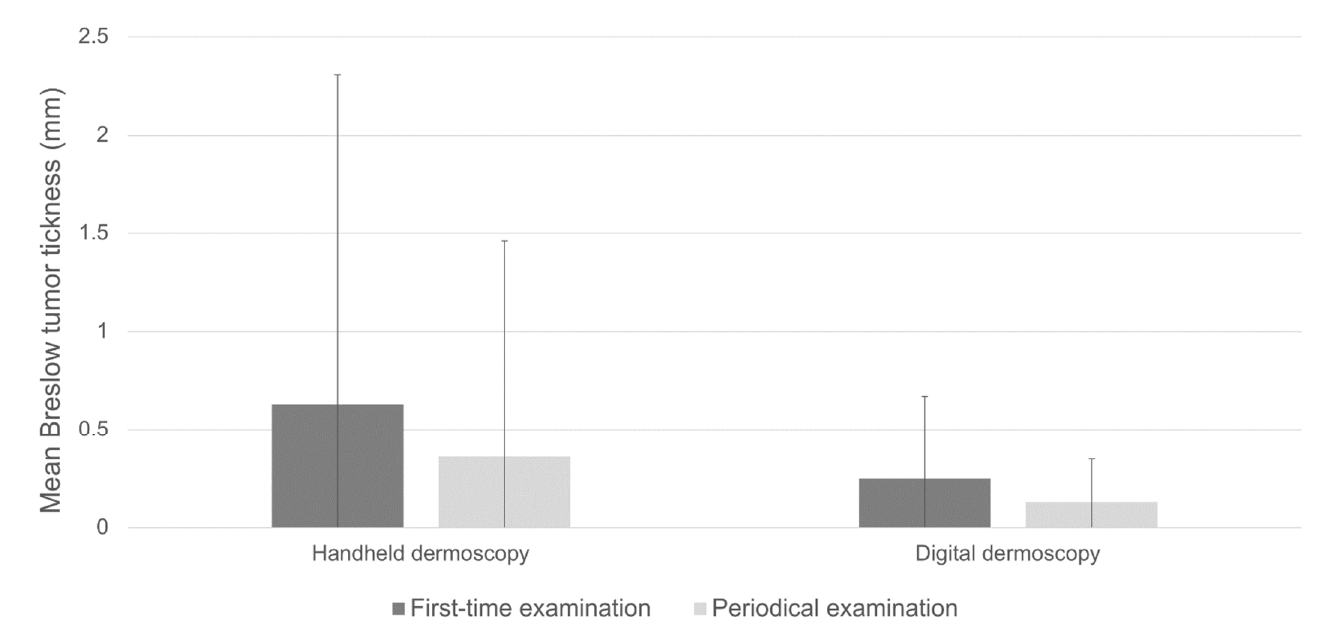
Figure 1. Breslow thickness in invasive melanomas diagnosed by handheld dermoscopy compared to digital dermoscopy.